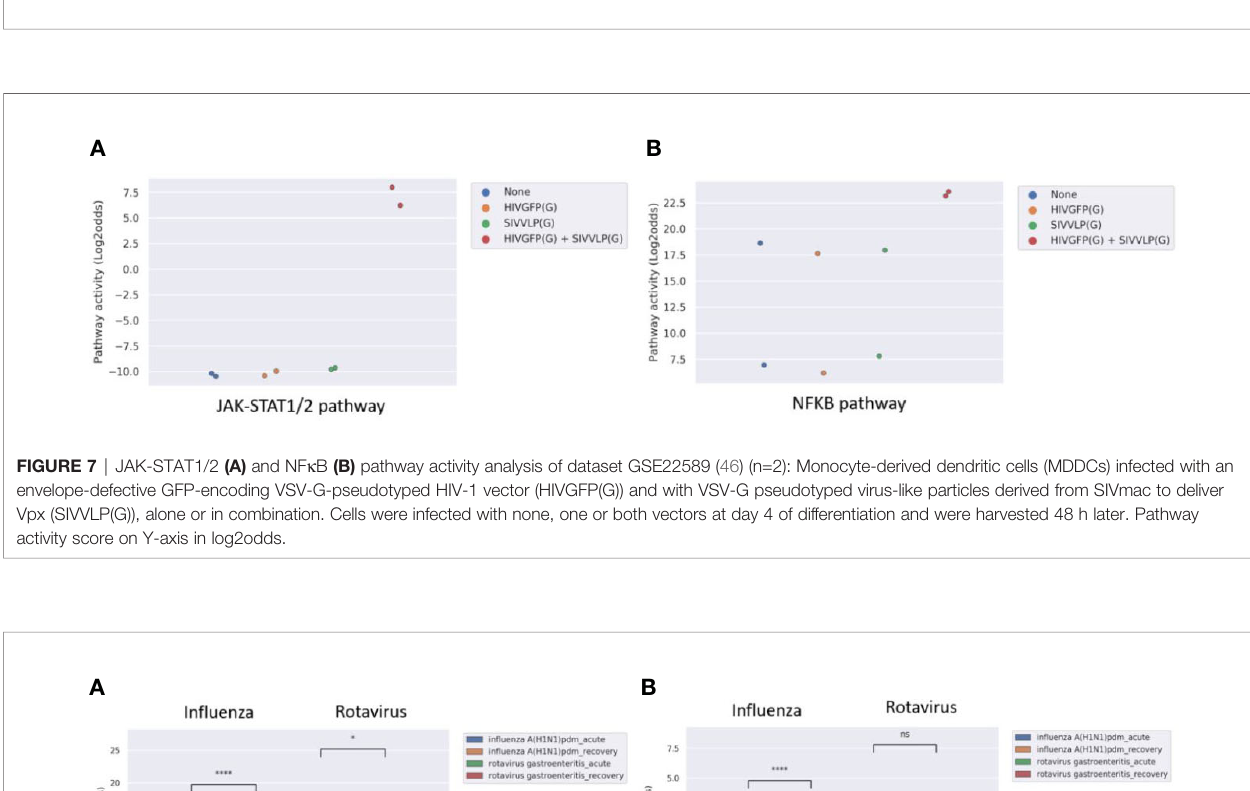
FIGURE 6 | JAK-STAT pathway activity induced by vaccination in healthy individuals with Yellow Fever vaccine (YFV-17, live attenuated yellow fever virus strain without adjuvant; A – D ) or in fl uenza vaccine (TIV, Trivalent In fl uenza Vaccine without adjuvant; E, F ). (A, B) : JAK-STAT1/2 (A) and JAK-STAT3 (B) pathway activity analysis of dataset GSE13486 (40): Yellow Fever vaccinated (YF-17D) healthy individuals at days 0, 1, 3, 7 and 21 after vaccination. PBMCs were isolated from blood and were used for analysis. Pathway activity score on Y-axis in log2odds. Two sided independent t-tests were performed; p-values are indicated in the fi gures as ***p < 0.001, ****p < 0.0001 or ns (not signi fi cant). (C, D) : JAK-STAT1/2 (C) and JAK-STAT3 (D) pathway activity analysis of dataset GSE51997 (21): Yellow fever vaccinated female volunteers. Peripheral blood was taken before and 7 days after immunization, and CD4 positive T-cells, CD16 negative and positive monocytes were isolated and used for analysis. Pathway activity score on Y-axis in log2odds. Two sided independent t-tests were performed; p-values are indicated in the fi gures as ***p < 0.001, or ns (not signi fi cant). (E, F) : JAK-STAT1/2 (E) and JAK-STAT3 (F) pathway activity analysis of dataset GSE29614 (41): Young adults vaccinated with In fl uenza TIV vaccine (Trivalent Inactivated In fl uenza Vaccine, GSK) during 2007/08 fl u season. PBMC samples were isolated at days 0, 3, 7 post- vaccination. Two sided Mann – Whitney – Wilcoxon tests were performed; p-values are indicated in the fi gures as ns (not signi fi cant). (G, H) : JAK-STAT1/2 (G) and JAK-STAT3 (H) pathway activity analysis of dataset GSE102459 (42): Human subjects were injected with M72/AS01E tuberculosis vaccine candidate at D0 and D30, whole blood samples are collected at D0, D30, D31, D37, D40, D44, and D47 and PBMC samples are collected at D0, D31, D44. Pathway activity score on Y- axis in log2odds. Two sided Mann-Whitney-Wilcoxon tests were performed; p-values are indicated in the fi gures. P-values indicate: ***p < 0.001, ****p < 0.0001 or ns (not signi